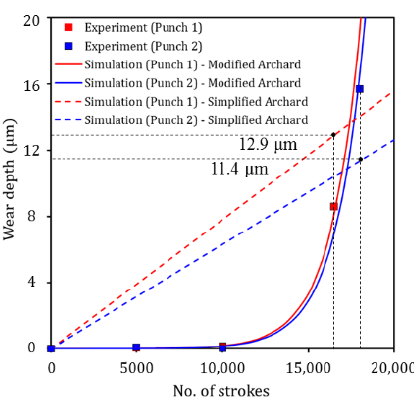
Figure 17. Simulation results based on simplified Archard’s wear model for CrN-coated punches.